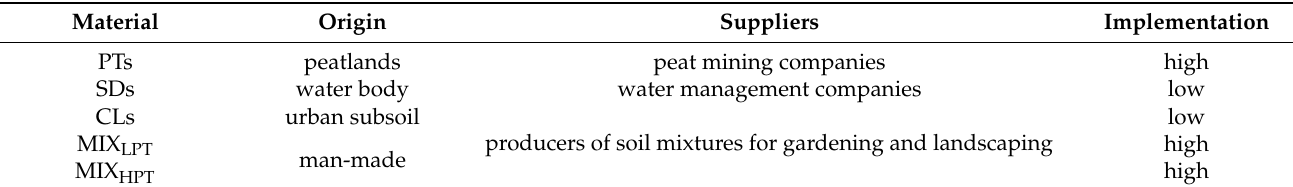
Table 1. The origin, suppliers, and implementation of the studied materials for Technosols’ construction (PTs, valley peat (n = 4); SDs, sediments (n = 2); CLs, cultural layers (n = 4); MIX LPT , mixture (n = 3) with low peat content; MIX HPT , mixture with high peat content (n = 3)).